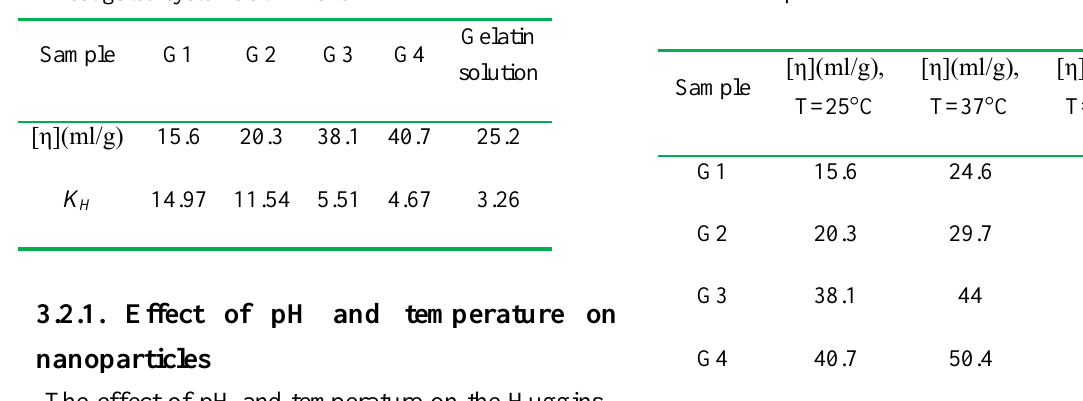
Table 4. Intrinsic viscosities of the investigated systems at different temperatures